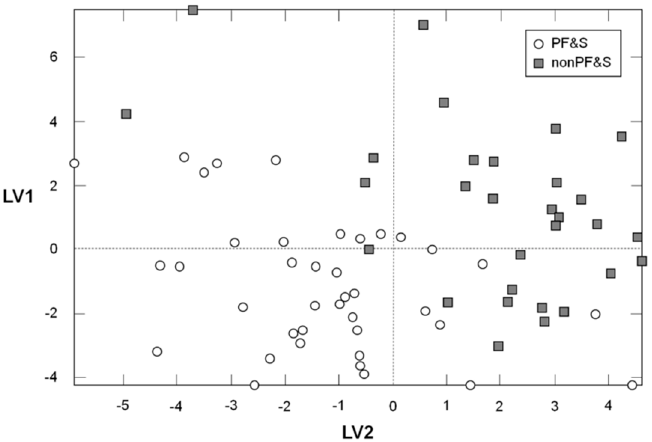
Figure 1. Scores plot showing the separation of participants according to the serum concentrations of amino acids and derivatives in the space spanned by the two latent variables (LV1 and LV2), as determined by Partial Least Squares–Discriminant Analysis (PLS-DA).